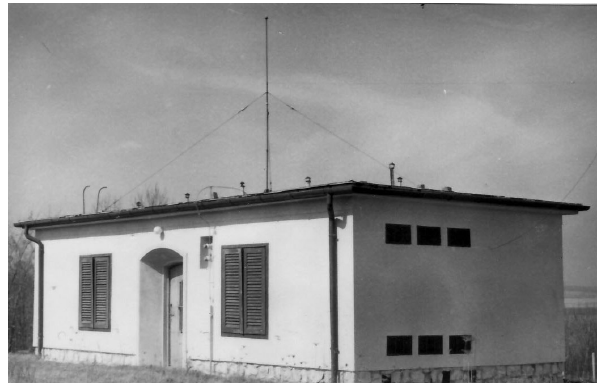
Figure 3. The sensor for point discharge current measurements on the roof of the atmospheric-electricity building. (Re-printed from Wesztergom,